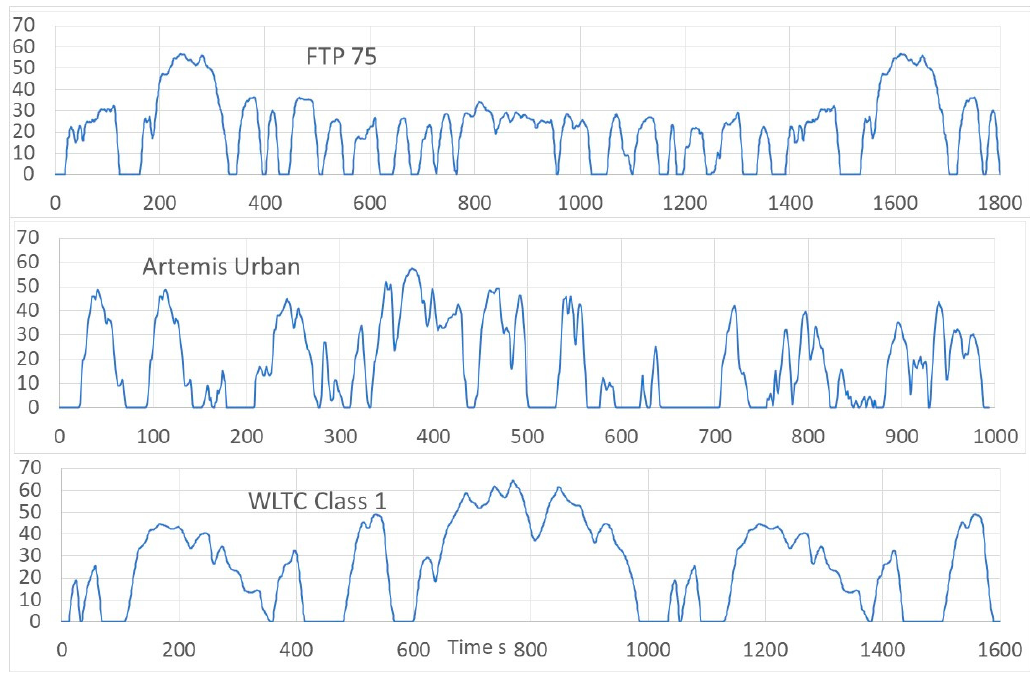
Figure 7. driving cycles used during the simulations: WLTC Class 1, FTP75 and Artemis Urban. Figure 7. Driving cycles used during the simulations: WLTC Class 1, FTP75 and Artemis